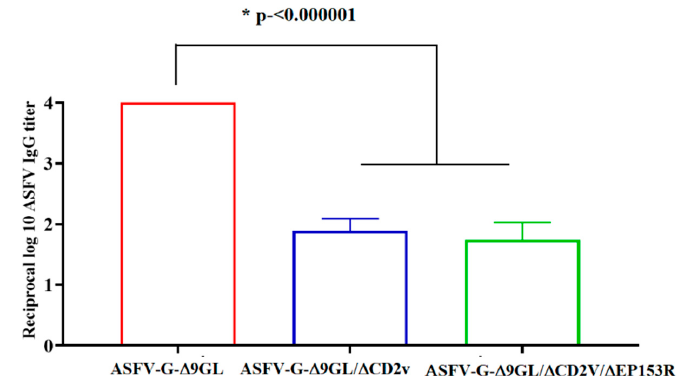
Figure 5. Anti-ASFV antibody titers detected in the sera of pigs IM inoculated with 10 3 TCID 50 of either ASFV-G- ∆ 9GL, ASFV-G- ∆ 9GL / ∆ CD2v, or ASFV-G- ∆ 9GL / ∆ CD2v / ∆ EP153R by day 35 pi (day of challenge). Statistical significance (*) determined using the Holm–Sidak method ( α = 0.05). Each day of sample collection was analyzed individually, without assuming a consistent SD. Analysis was conducted on Graphpad Prism software version